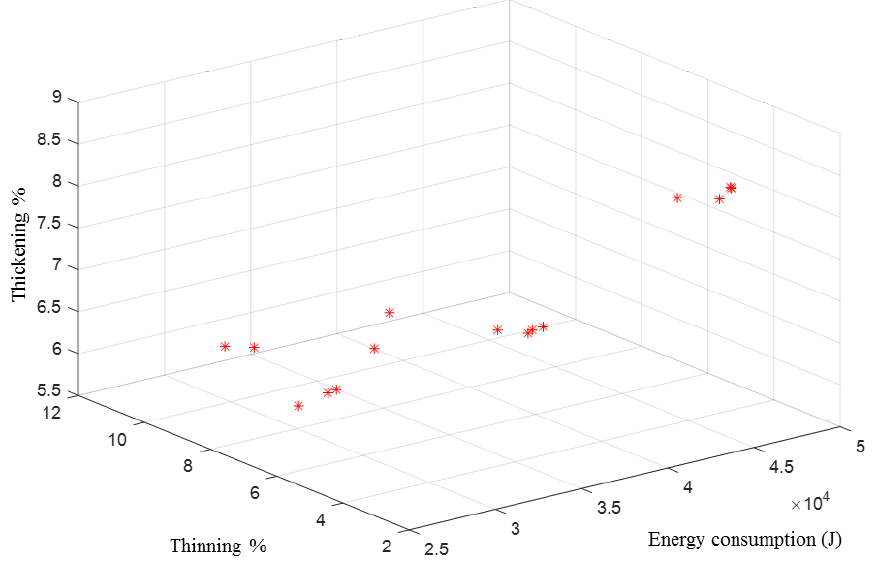
Figure 10. Pareto optimal solutions of ZK60 magnesium alloy hot stamping. Table 4. Compromise solutions and their corresponding indices.